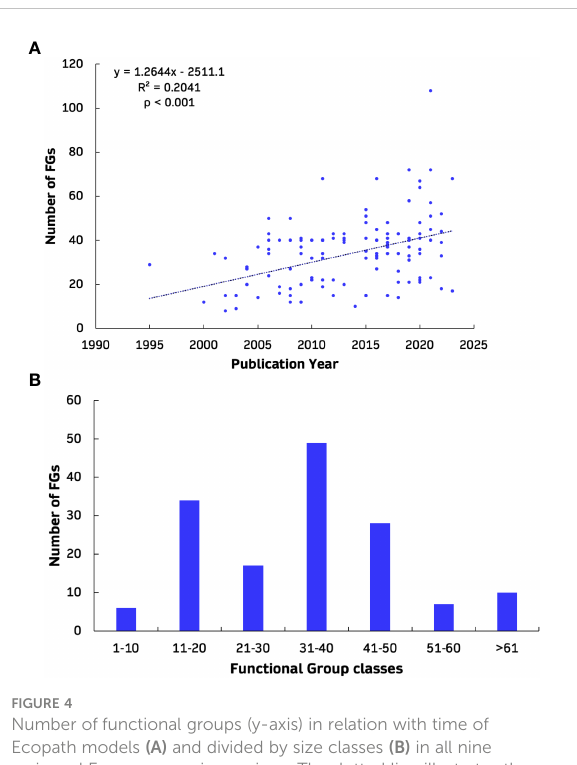
FIGURE 4 Number of functional groups (y-axis) in relation with time of Ecopath models (A) and divided by size classes (B) in all nine reviewed European marine regions. The dotted line illustrates the trend identi fi ed with a linear model, indicating a correlation with highly statistical signi fi cance (p value < 0.001).